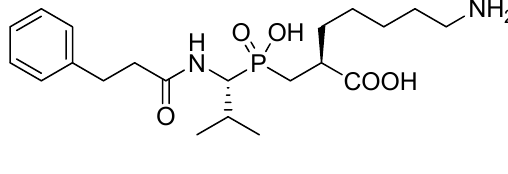
NH OHO H N P S COOH O O 122 , BX 528, IC = 2 nM (TAFIa) 50